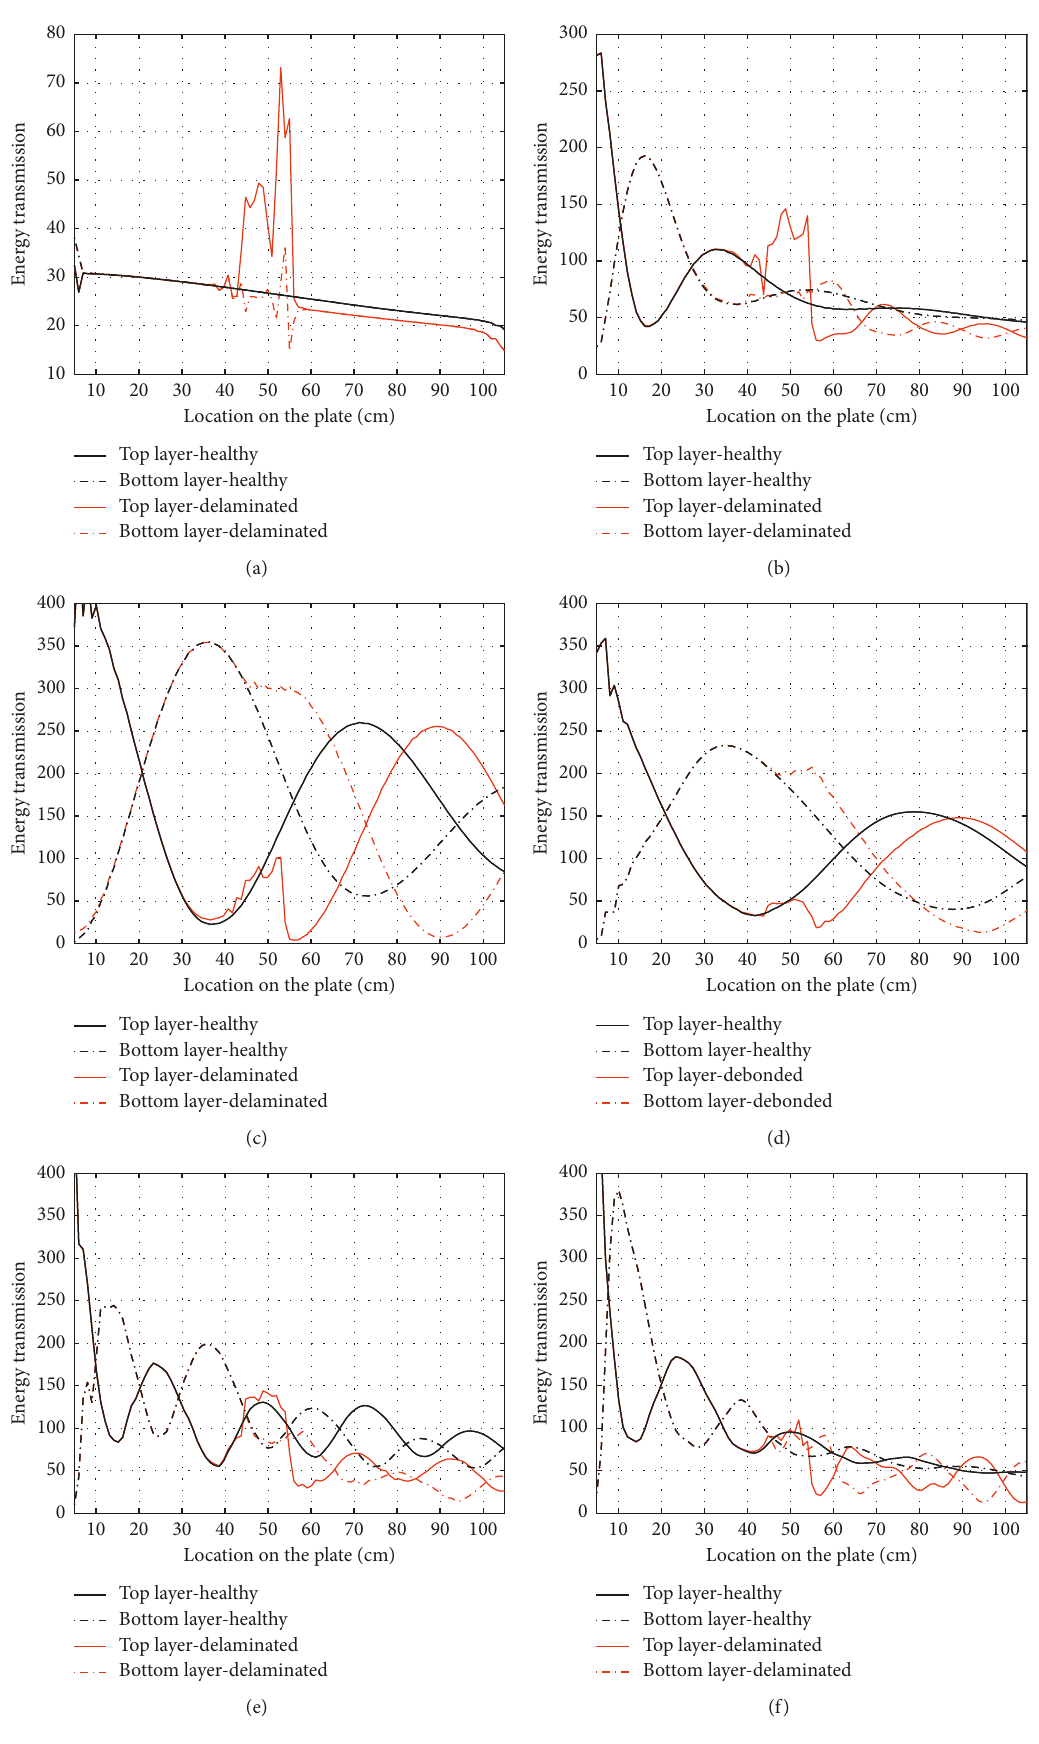
Figure 7: Energy response in the top and bottom laminate skins for both healthy and delaminated plates for excitation frequencies of (a) 15kHz, (b) 40kHz, (c) 60kHz, (d) 80kHz, (e) 100kHz, and (f)